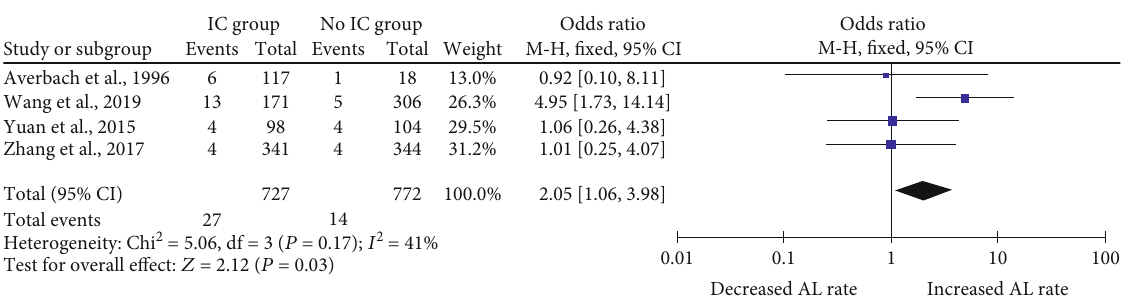
Figure 2: IC post colorectal surgery and anastomotic leak wh